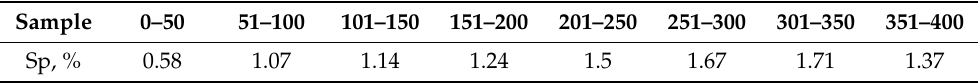
Table 3. The values of pooled standard deviation, calculated from the measured value of 50